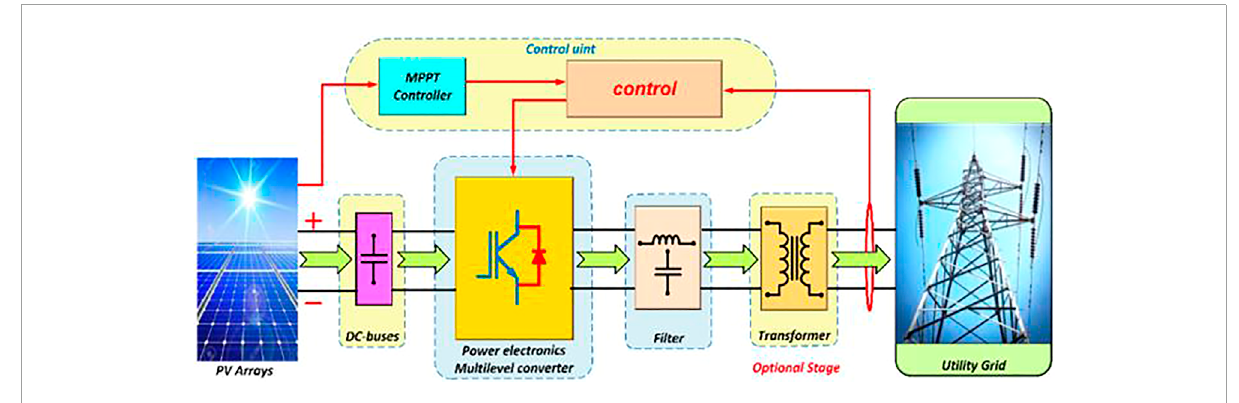
FIGURE 1 Pv system with MLI.